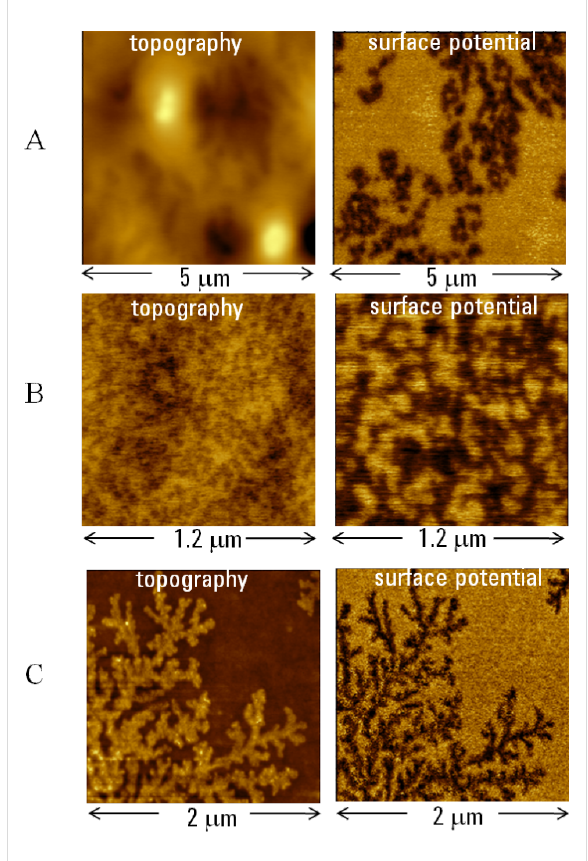
Figure 6: Topography and surface potential images of the films of a latex blend of poly( n -butyl acrylate) and poly(pentafluorostyrene) are presented in A and B . The contrast covers height variations in the 0–140 nm and 0–10 nm ranges in the topography images and poten- tial changes in the 0–0.4 V and 0–1V ranges in the surface potential images. Topography and surface potential images of a film of a PMMA and PVDF blend are shown in C . The contrast covers the height corru- gations in the 0–10 nm range in the topography image and the poten- tial variations in the 0–1 V range in the surface potential